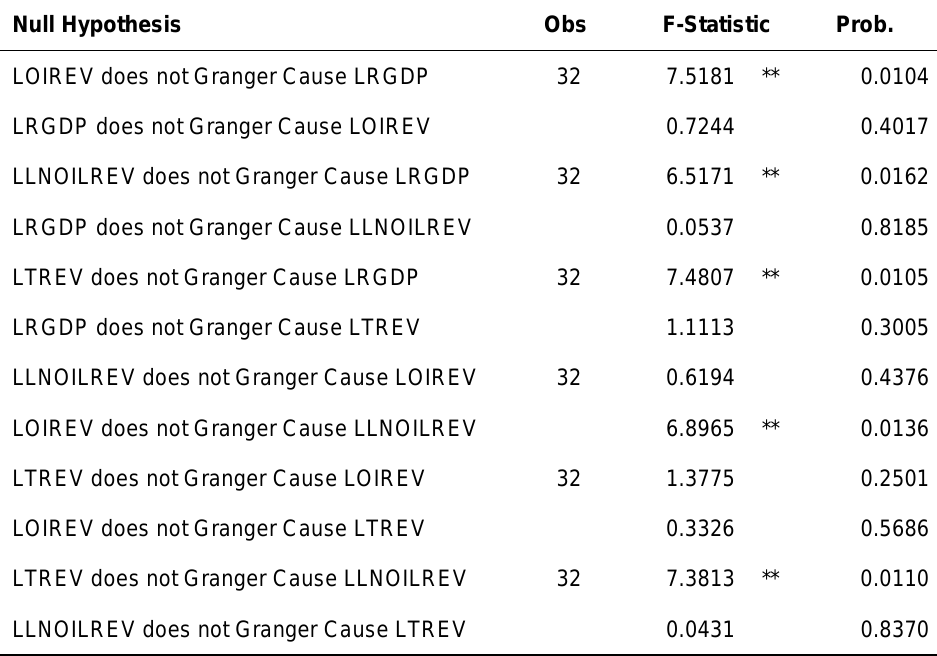
Table 4. Granger-Causality Test